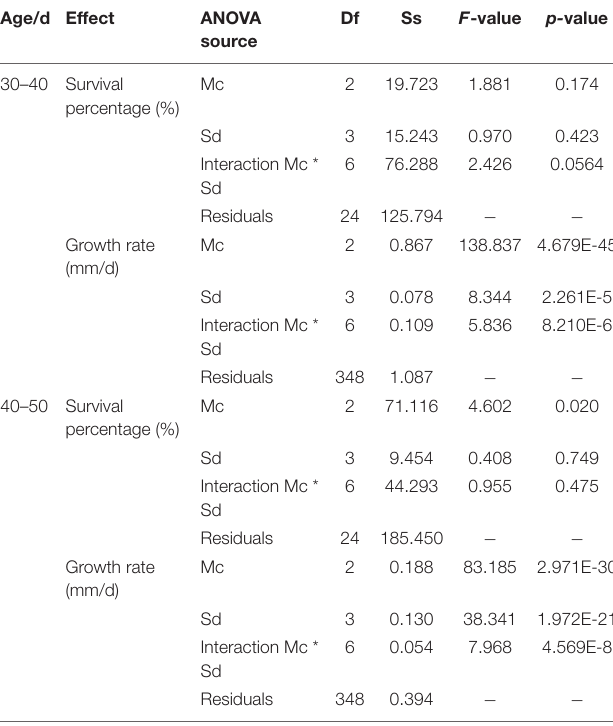
TABLE 2 | Two-way ANOVA table testing the effects of microalgae concentration and stocking density on the survival and growth of Mulinia lateralis spat. Age/d Effect ANOVA